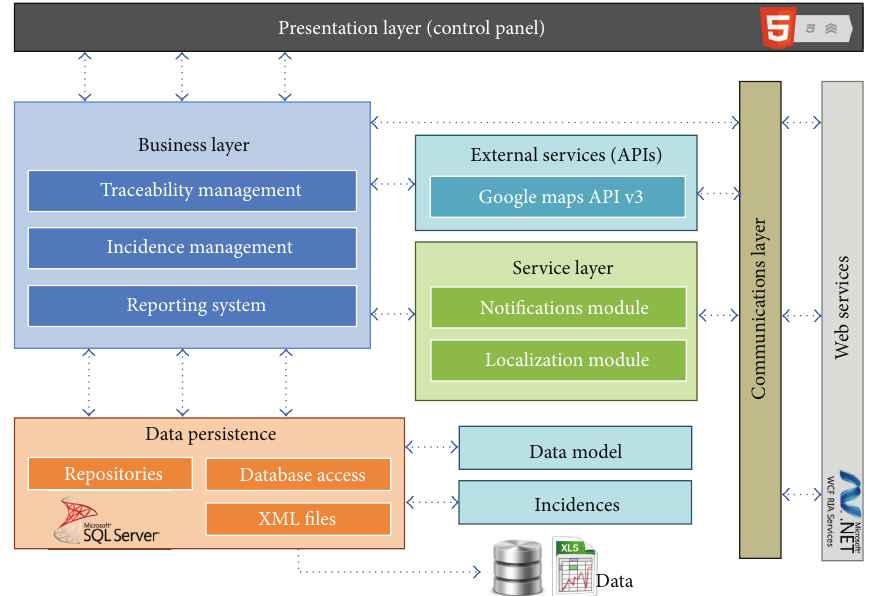
Figure 8: Architecture of the management software